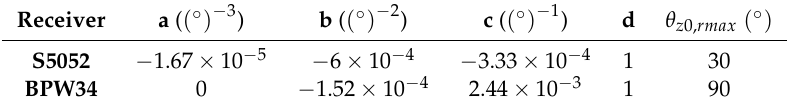
Table 1. Parameters of the angular receiver sensitivity.